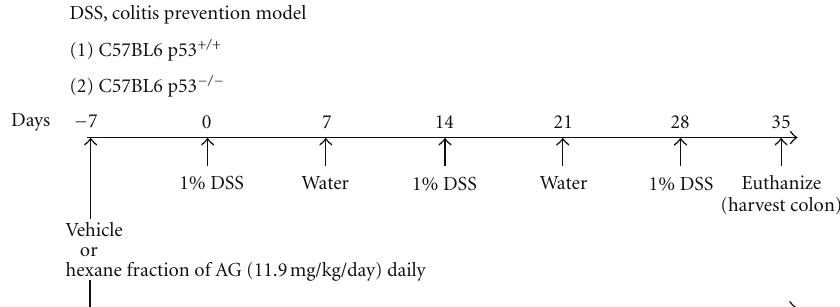
Figure 1: Experimental protocol for the DSS, prevention mouse model of colitis. 11.9 mg/kg/day of HAG or vehicle (1 × PBS) was given to the respective group of mice by oral gavage 7 days prior to the first DSS cycle and continued daily until the end of the experiment (2.5 cycles). The mice (both C57/BL6 p53 − / − and C57/BL6 p53 + / + ) were euthanized on day